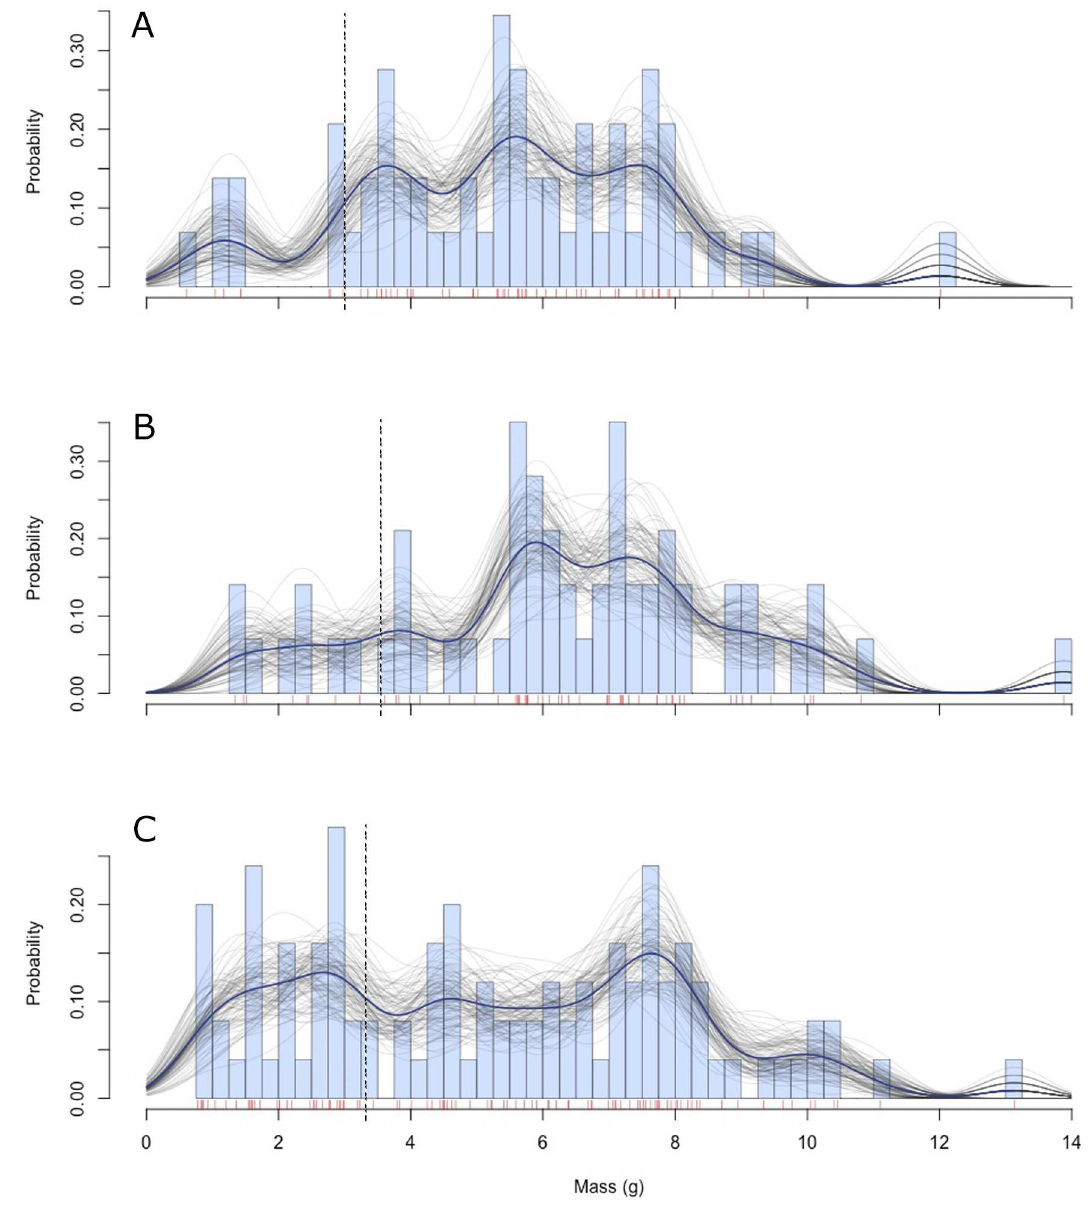
Fig 4. Frequency distributions of fruit sizes hoarded by A. A . olivaceus , B. P . darwini and C. O . degus . The dashed vertical lines indicate the mean size of fruits offered to each species duringthe trials (see text). Vertical marks along the seed mass axis represent uniquedocumentedhoardedfruits. We includeda non-parametric smoothing spline fit (dark blue line) to the empiricaldistancedistribution together with bootstrapped estimates (grey lines) to allow comparisons across plots.